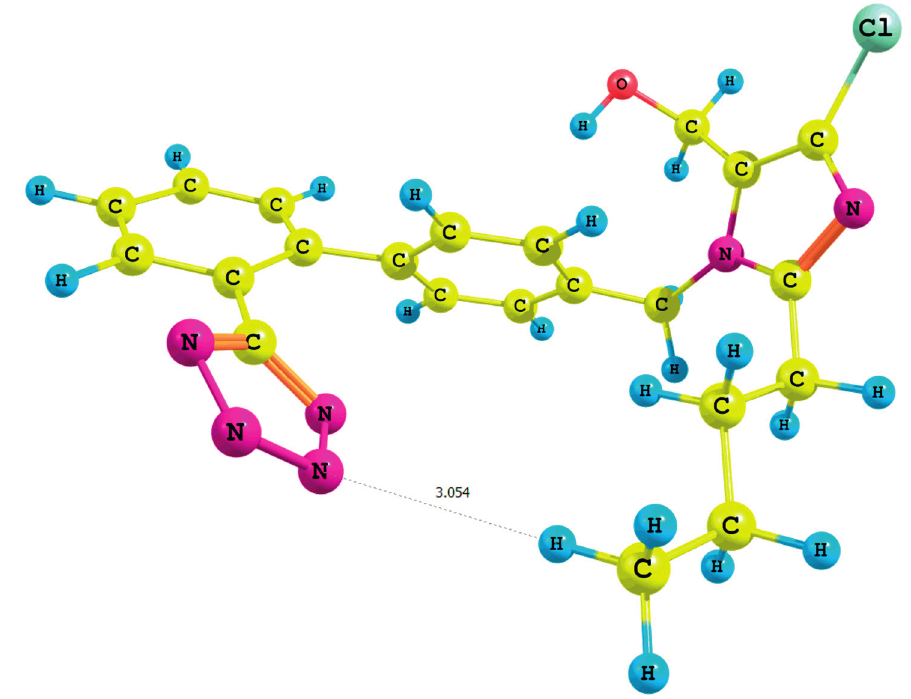
Figure 2. Optimized structure of the syn -losartan anion 1 (PBE1PBE/6-31G(d,p) level of theory, Rotamer VIII , CPCM solvation